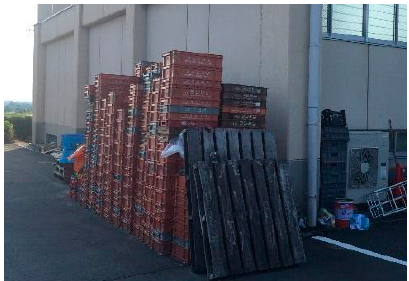
Figure 17. Nishihara Village Office during the 2016 Kumamoto Earthquake. Uncollected pallets (photographed by Numada).